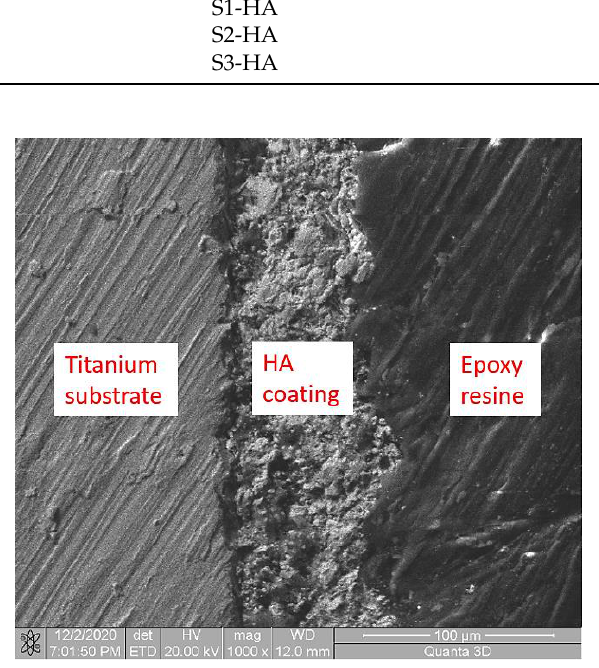
Figure 4. Representative aspects layer of HA on titanium alloys.